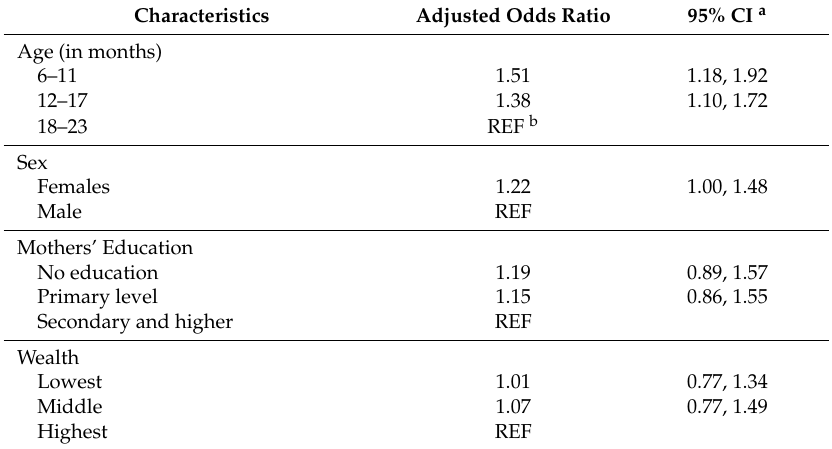
Table 2. Odds of vitamin B12 deficiency among children six to 23 months by sociodemographic, nutritional and clinical characteristics, Kapilvastu and Accham districts, Nepal